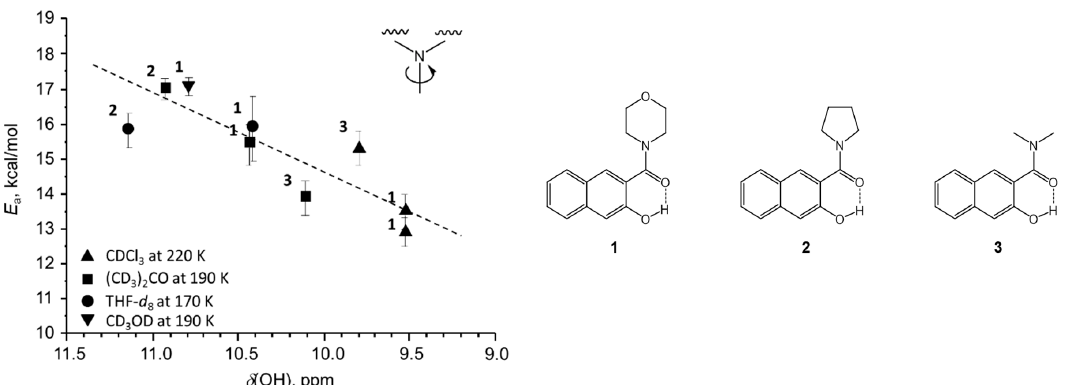
Figure 16. The dependence of the energy barrier ( E a ) of the rotation around the C-N amide bond from Table 1. NMR chemical shift of the hydroxyl group for (3-hydroxynaphthalen-2-yl), (morpholin-4-yl)methanone ( 1 ), (3-hydroxynaphthalen-2-yl)(pyrrolidine-1-yl)methanone ( 2 ), and 3-hydroxy-N,N-dimethylnaphthalene-2-carboxamide ( 3 ), dissolved in the solvents listed in the plot. Reprinted from Ref. [68]. Copyright 2015, Elsevier.